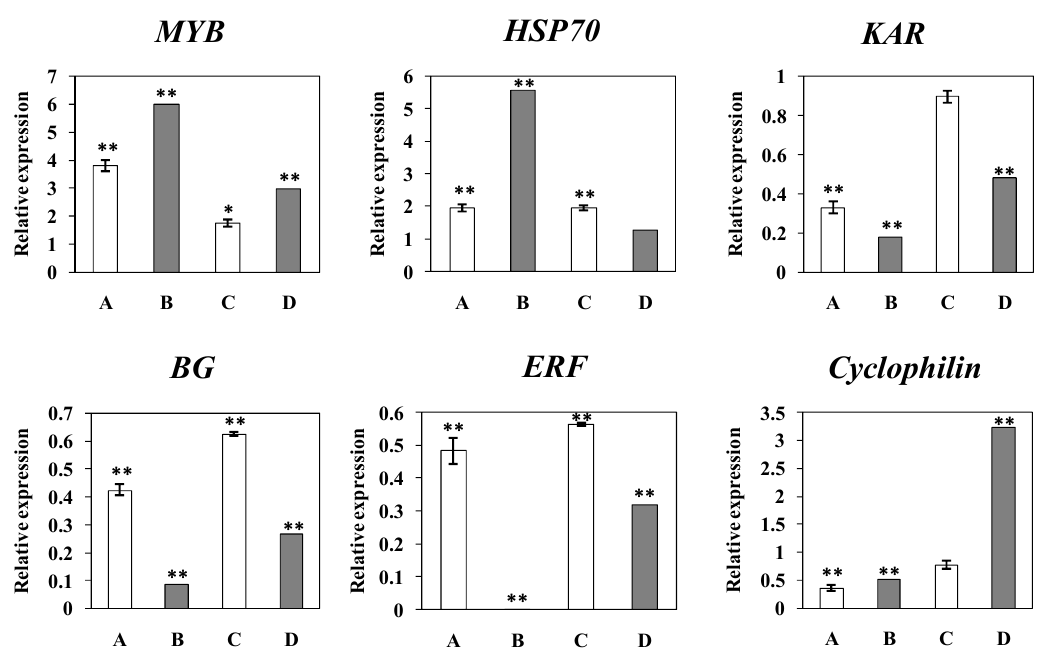
Figure 5. Comparison of the expression levels in ponkan leaves infected with C Las relative to their controls of six of the representative genes obtained by real-time PCR (A,C) and by digital gene expression (DGE) profiles (B,D). A,B: at 13 wpi; C,D: at 26 wpi. * and ** indicate significant changes at p < 0.05 and p < 0.01, respectively. MYB , MYB family transcription factor; HSP, heat-shock proteins; KAR , ketol-acid reductoisomerase; BG , β -1,3-glucanase; ERF , Ethylene response factor.